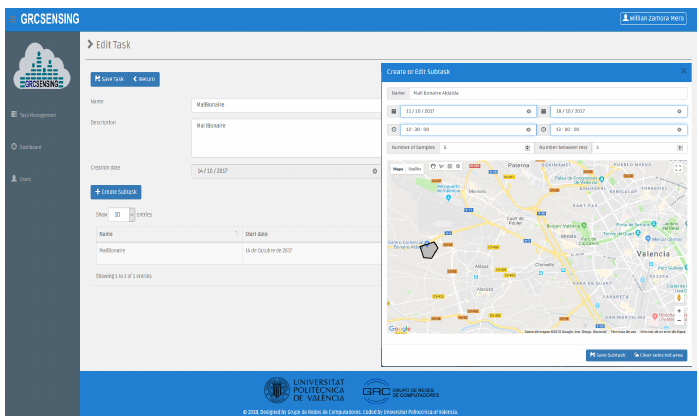
Figure 12. Task specification at the back-end server for noise distribution analysis at the Bonaire shopping mall.